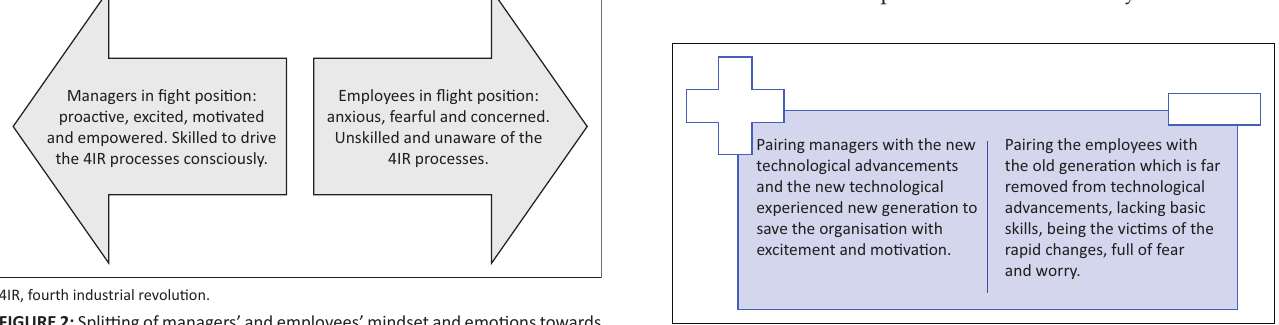
FIGURE 2: Splitting of managers’ and employees’ mindset and emotions towards the fourth industrial revolution.